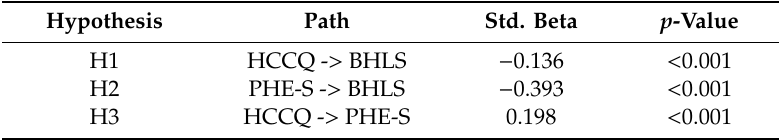
Table 5. Path estimates ( β ) for testing Hypotheses 1–3.